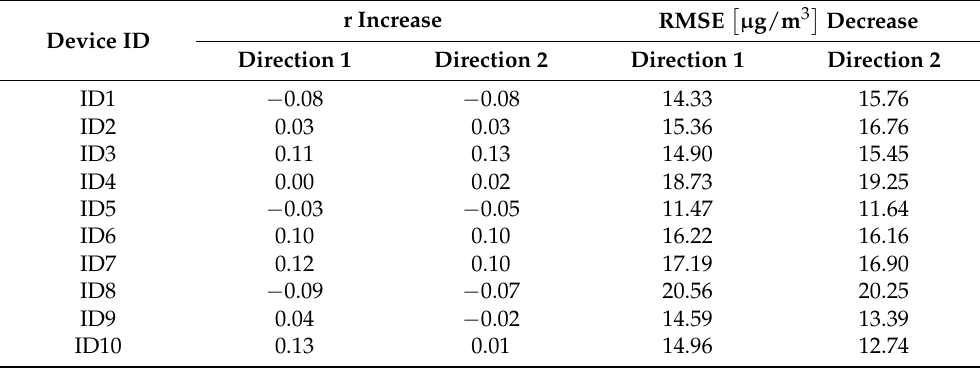
Table 5. Results of the PM 10 calibration propagation in May, improvements in comparison to the parameters before